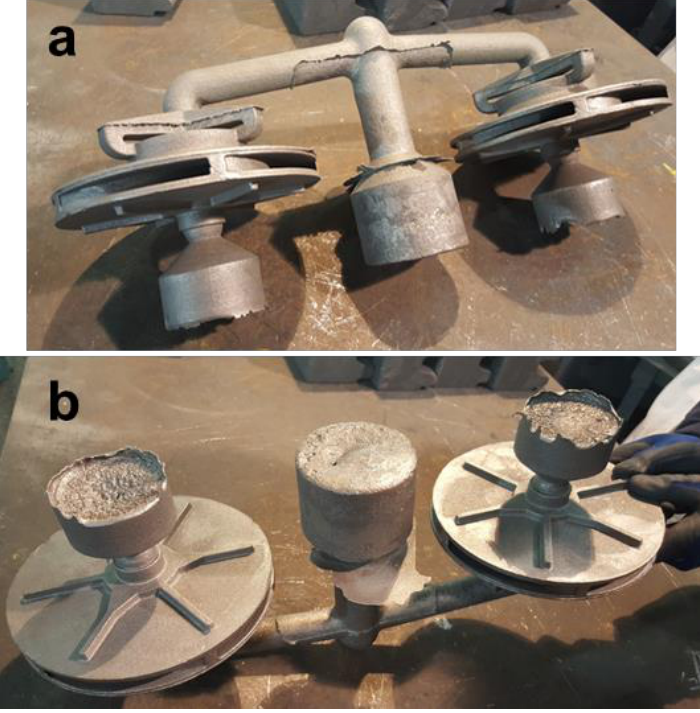
Figure 7. View of the impellers after casting, cooling, and mould separation: ( a ) top view, ( b ) downside view.